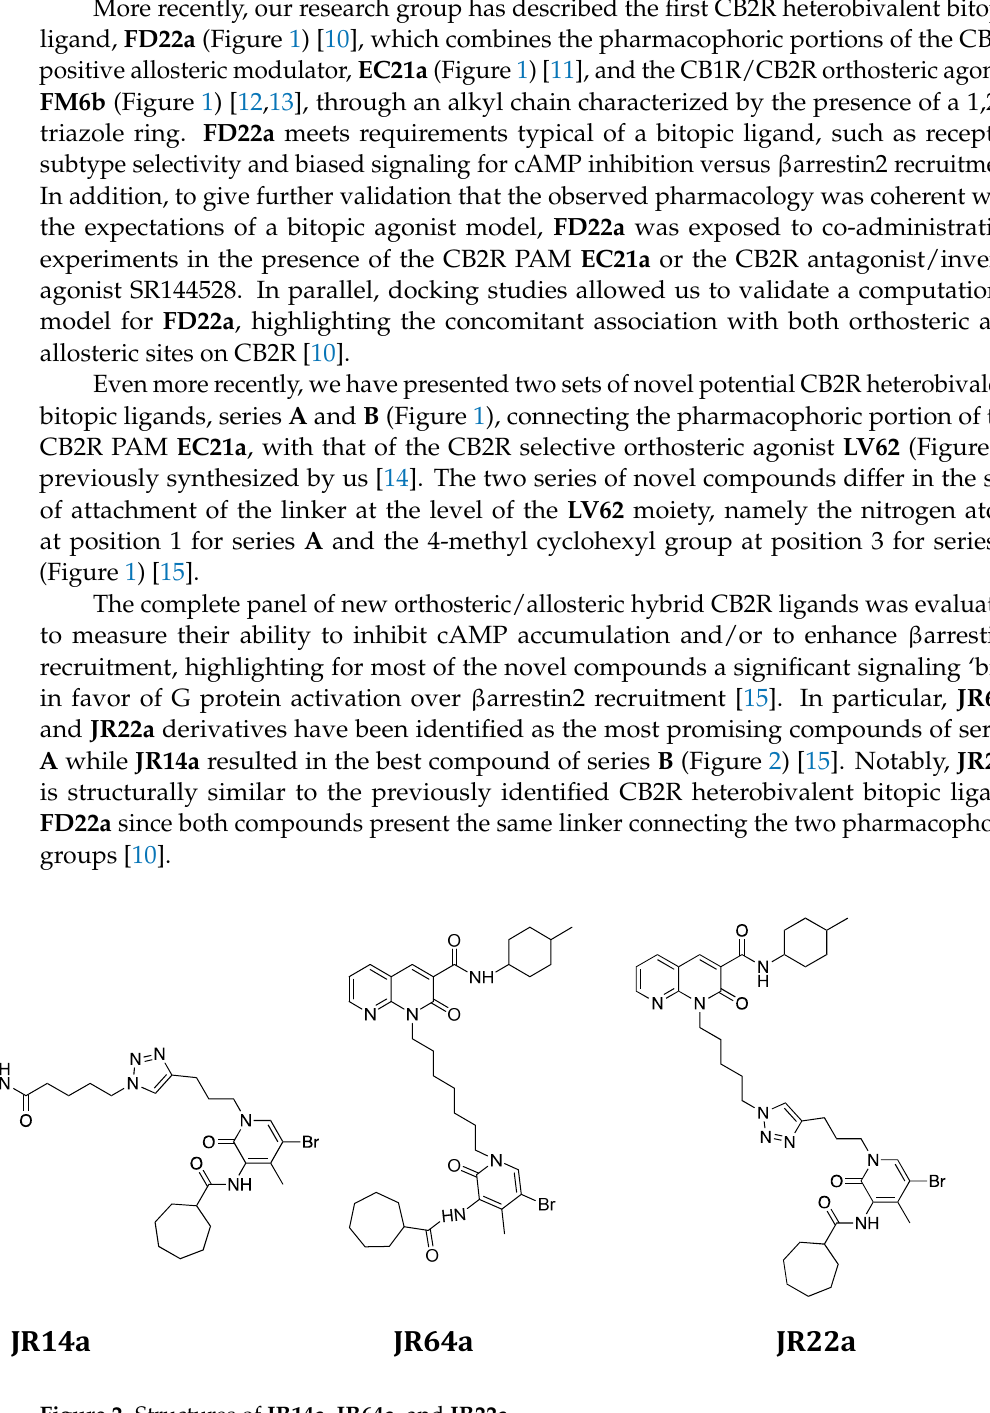
Figure 2. Structures of JR14a , JR64a , and JR22a .